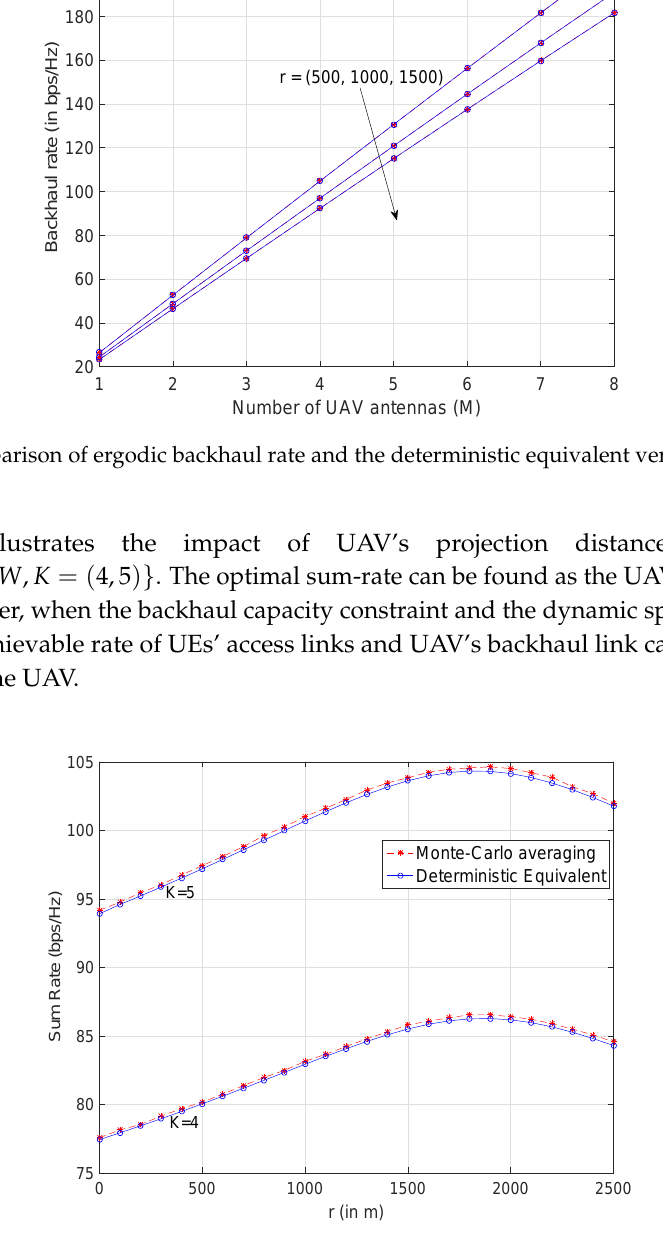
Figure 4. Comparison of ergodic sum-rate of UEs versus UAV’s projection